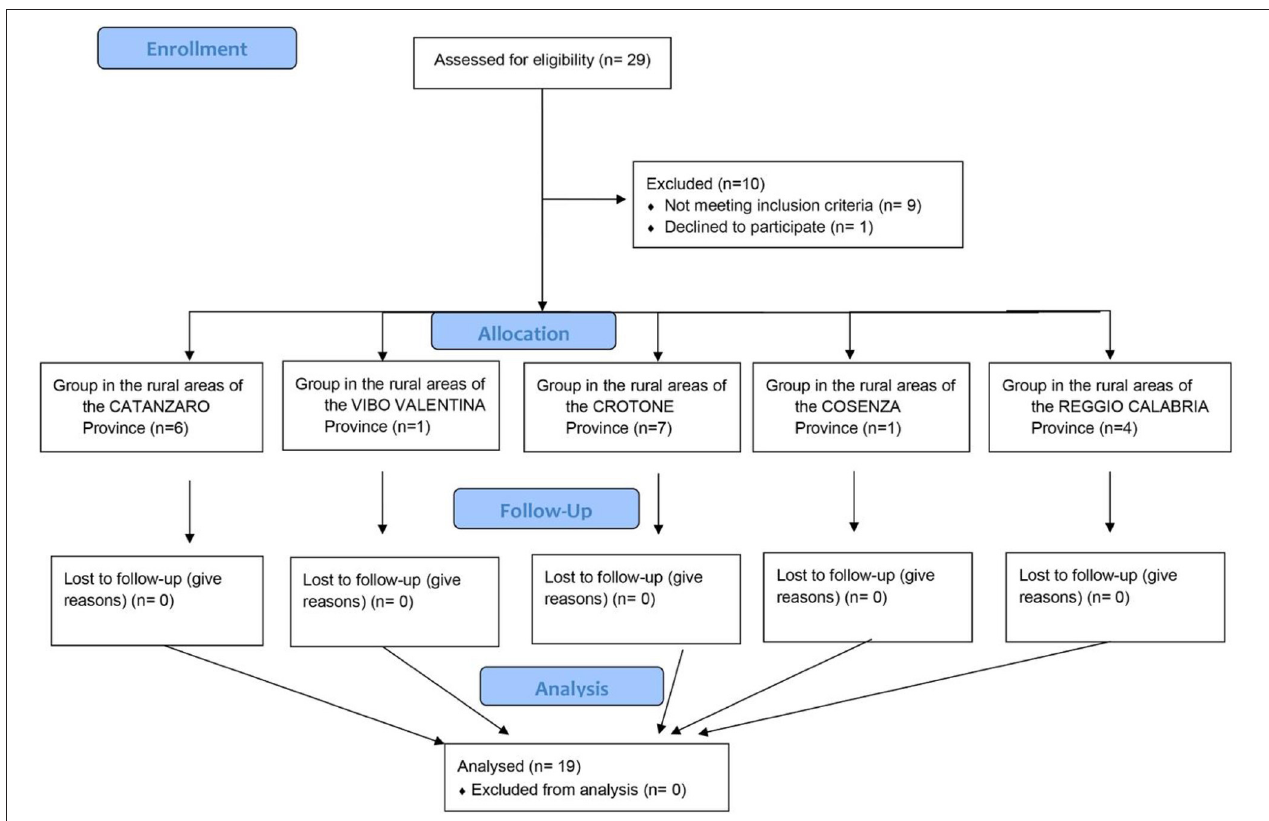
FIGURE 2 | Flow diagram showing the phases of parallel trial of patients with stroke who underwent TR treatment in Calabria provinces.